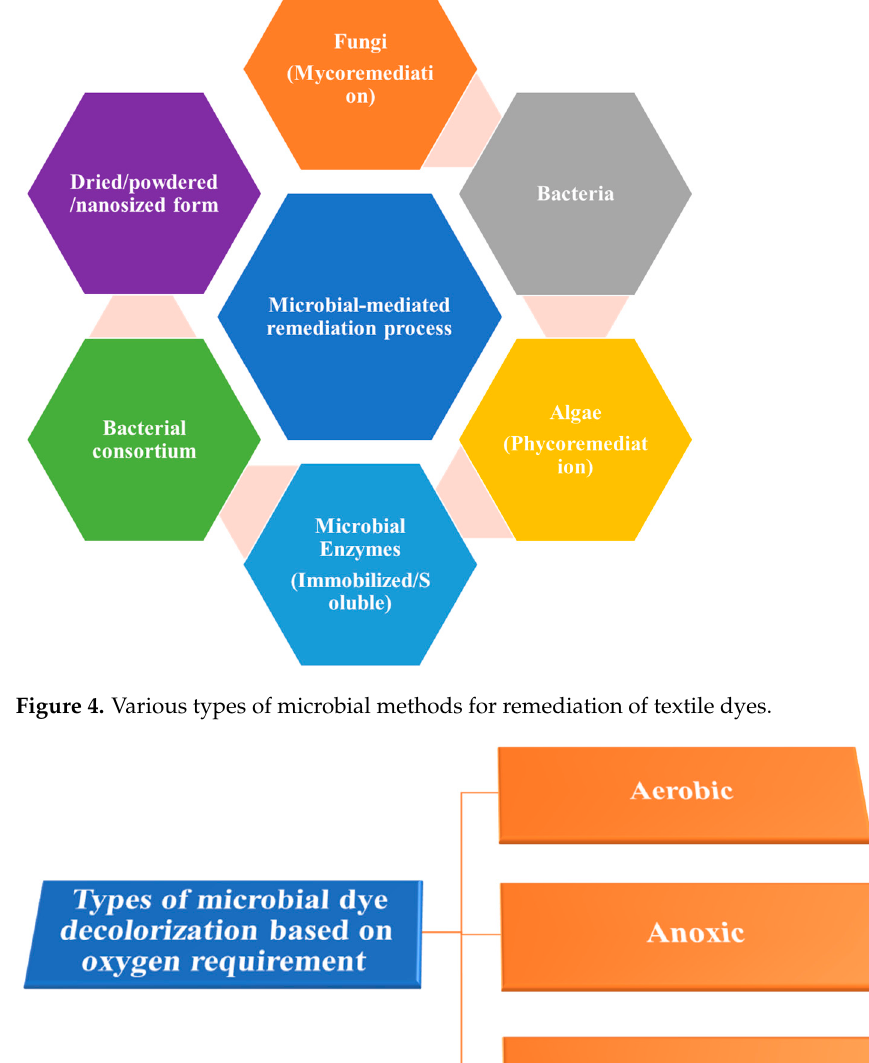
Figure 5. Various types of microbial degradation of dyes based on oxygen environment.